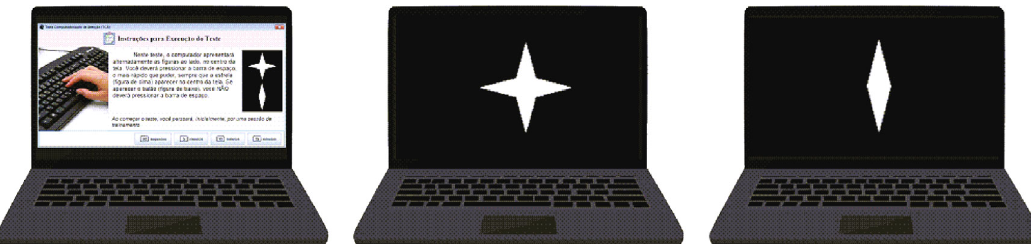
Figure 1: Schematic overview of the set-up of the laptop and of the target (star) and nontarget